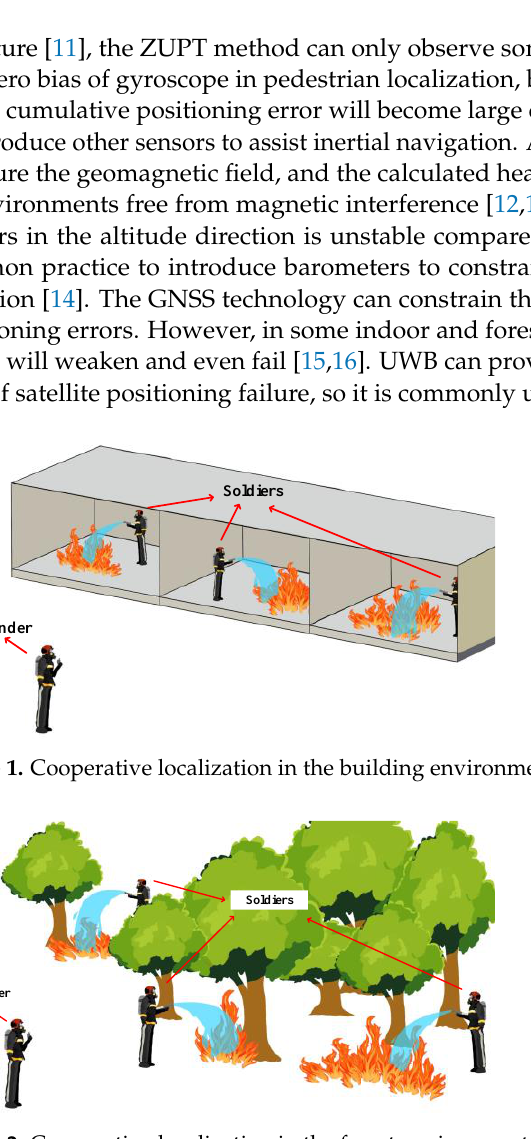
Figure 2. Cooperative localization in the forest environment.